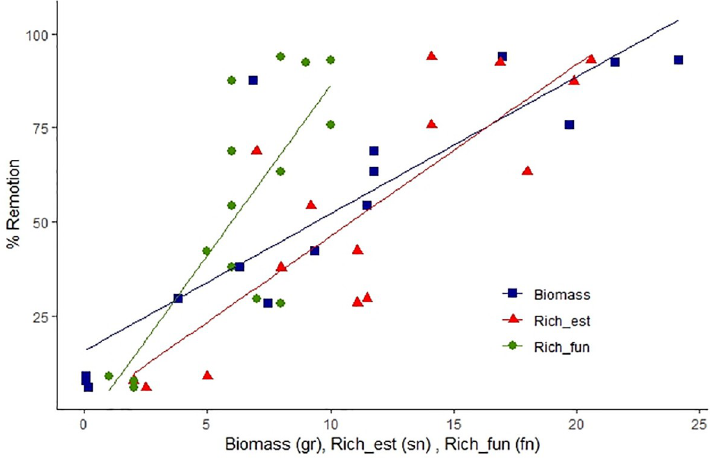
Fig 4. Relationship between biomass, estimated richness and functional richness in each studied habitat and excrement removal. Measurement units (sn: Species number; fn: Functional groups number; gr: Grams).